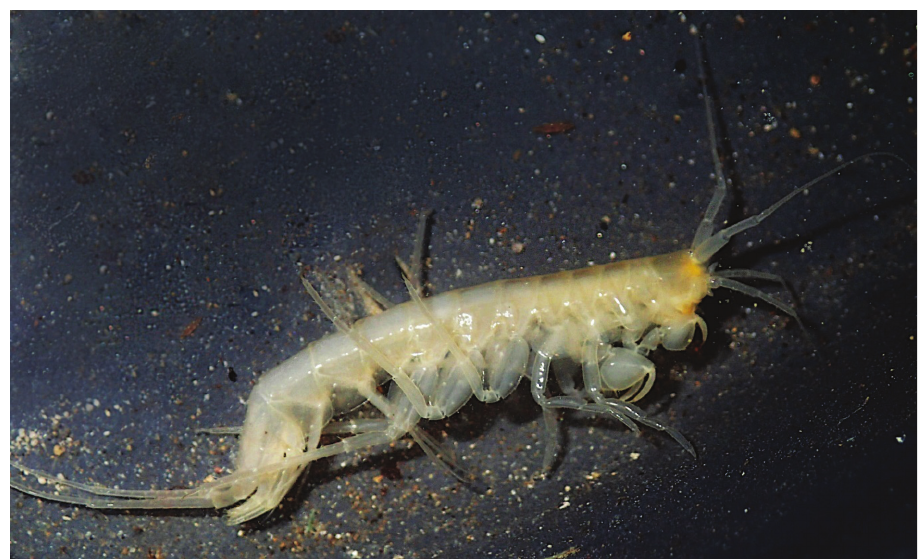
Figure 5. Niphargus enslini , live male from the Blätterteighöhle (Photo: Bernd